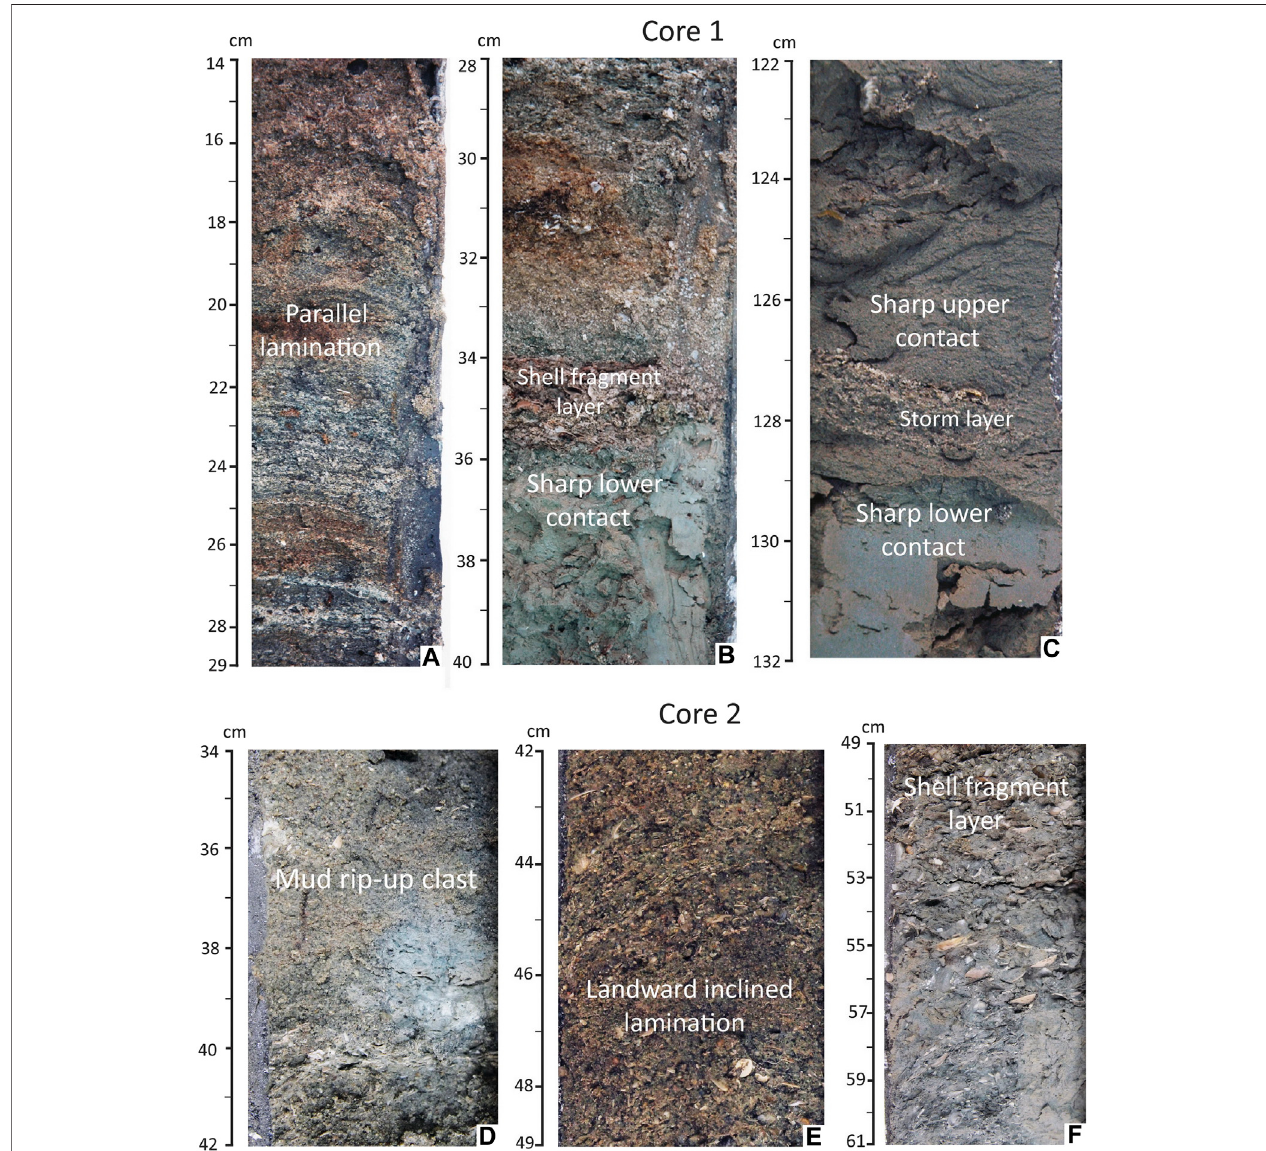
FIGURE5 | Close upofthe internal sedimentarystructuresofthe sand sheets from cores1 and 2showing (A) parallellamination, (B) layers ofshell fragments with sharp contact with mud underneath, (C) sand sheet between upper and lower muds, (D) mud rip-up clasts, (E) landward inclined lamination, and (F) marine shell